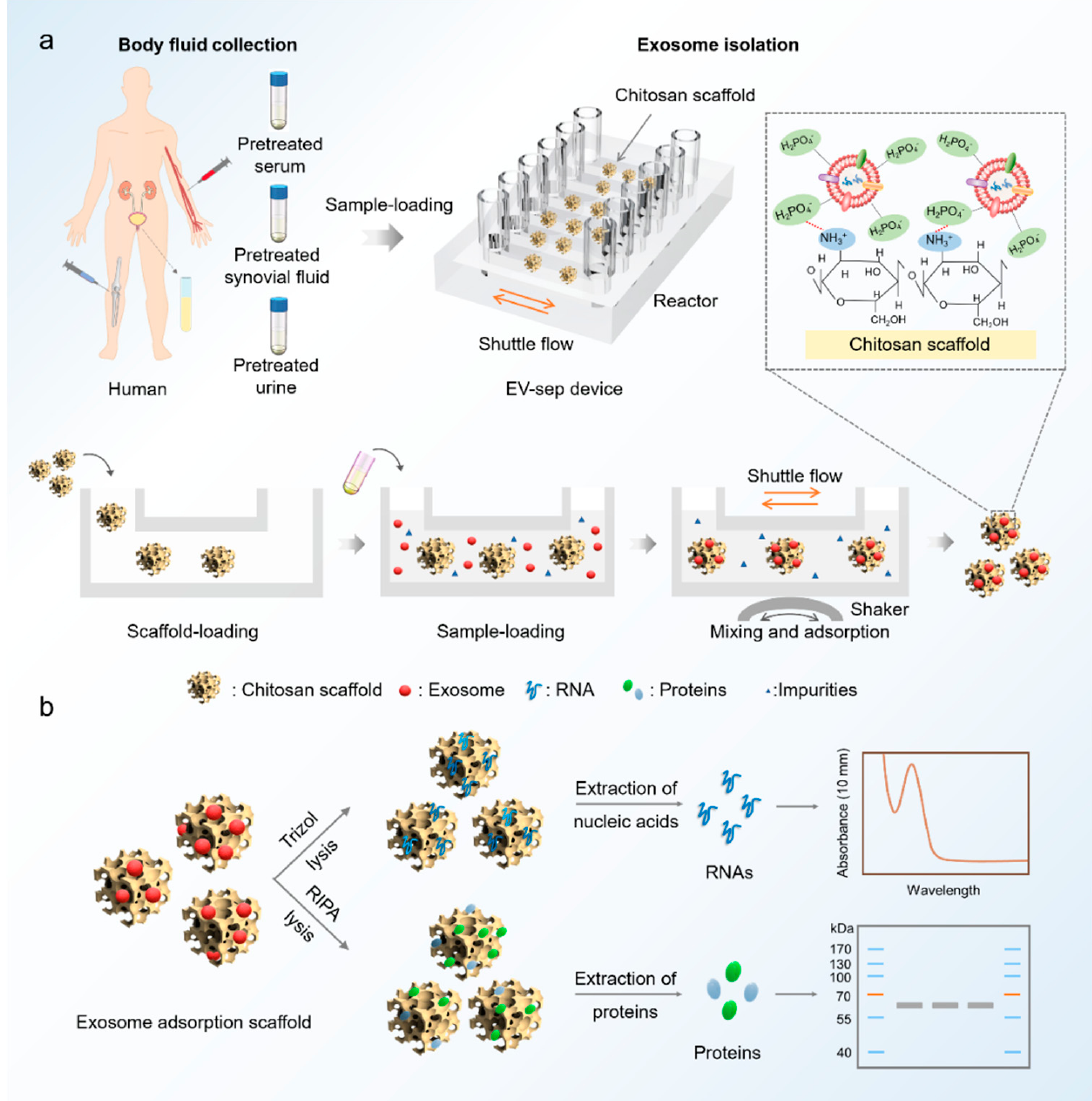
Figure 1. The illustration of exosome isolation from body fluids using EV ‐ sep device. ( a ) Schematic diagram of the device for exosome isolation from serum and urine of human. In an acidic environment, – NH 3+ on chitosan can combine with anionic phosphate groups on phospholipid bilayer of exosomes. ( b ) The exosomes captured by the EV ‐ sep device can be lysed online for nucleic acids or proteins analysis subsequently.